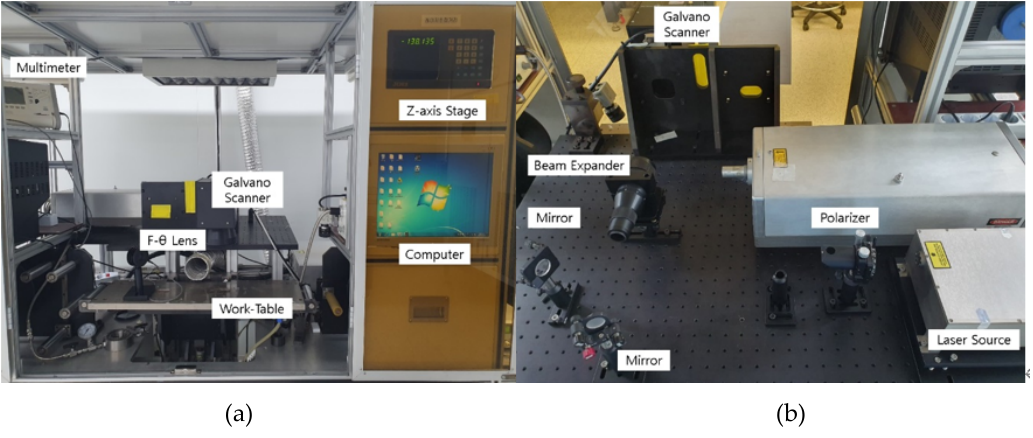
Figure 1. Laser system: ( a ) laser set-up; ( b ) optical system. Table 1. Specifications of the 355 nm UV pulsed laser.